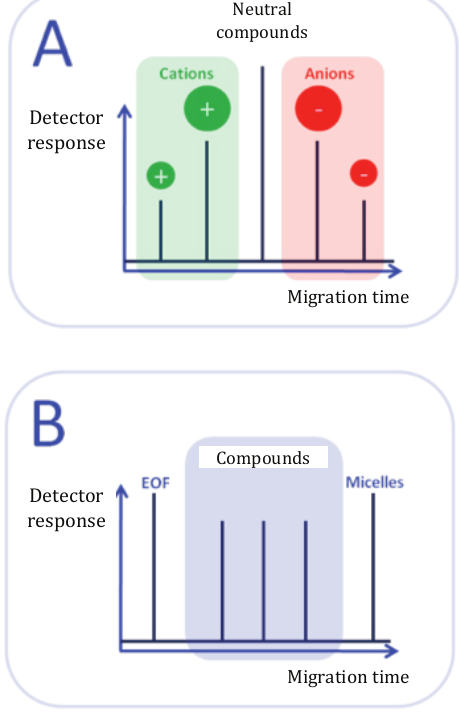
Figure 5 : Diagram illustrating the separation of compounds, A: CZE in positive mode B: in MEKC mode (positive mode with negatively charged micelles)